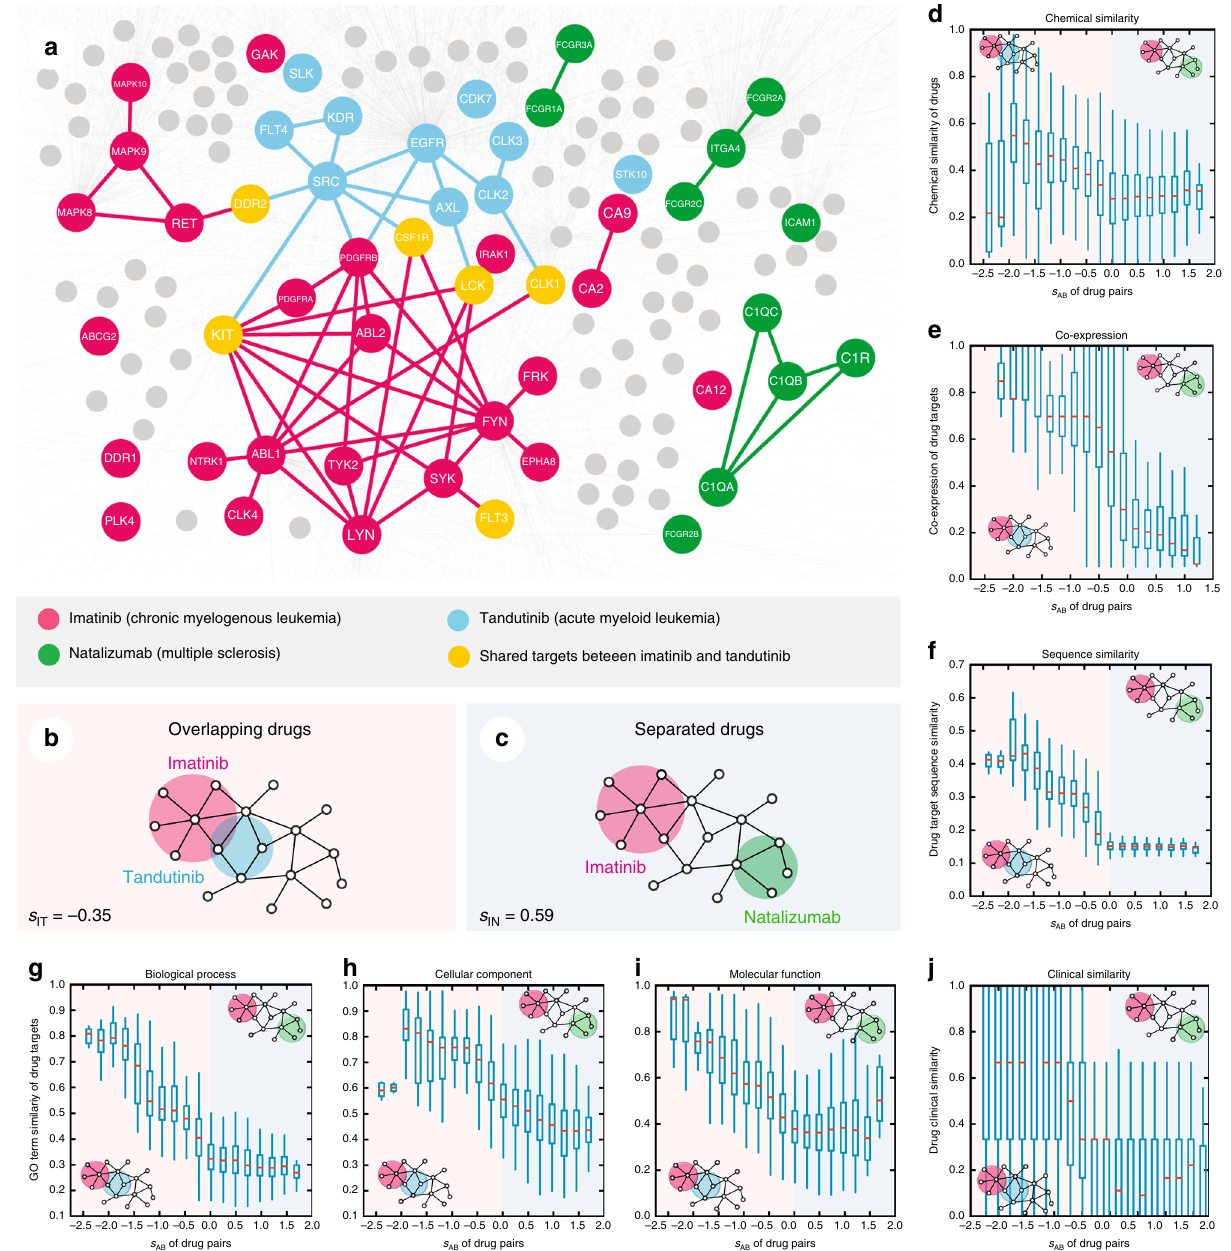
Fig. 1 Network-based model of drug – drug relationship. a A subnetwork of the human interactome illustrating the network-based relationship between drug targets associated with three drugs (imatinib [I], tandutinib [T], and natalizumab [N]). b , c The de fi nition of drug pairs that are topologically overlapping (s AB < 0, b ) or topologically separated (s AB ≥ 0, c ). d – j The interplay between topological separation of drug pairs and fi ve types of drug pro fi les: drug – drug chemical similarity ( d ); drug target-encoding gene co-expression pattern across human tissues ( e ); drug target protein sequence similarity ( f ). Using the Gene Ontology (GO) annotations, we determine for each drug how similar its associated target-encoding genes are in terms of their biological processes ( g ), cellular component ( h ), and molecular function ( i ); and clinical similarity ( j ) of drug pairs derived from Anatomical Therapeutic Chemical Classi fi cation Systems codes (see Methods). Overlapping drug pairs are highlighted in orange (s AB <0); topologically separated drug pairs are highlighted in blue (s AB ≥ 0)